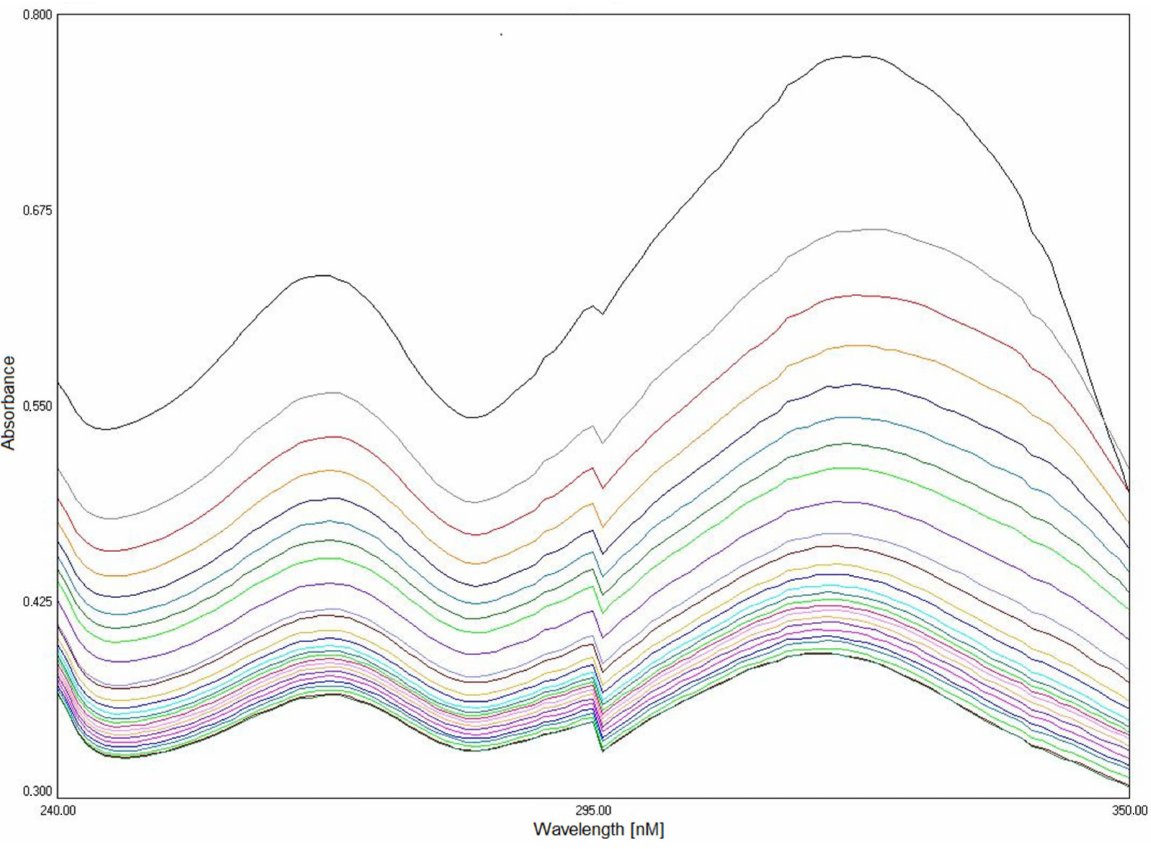
Figure 8. The changes in absorbance spectra of compound 3e during spontaneous hydrolysis. The spectrum was monitored for 250 min with 10 min intervals in 0.05 M phosphate buffer (pH 7.3, 25 °C).